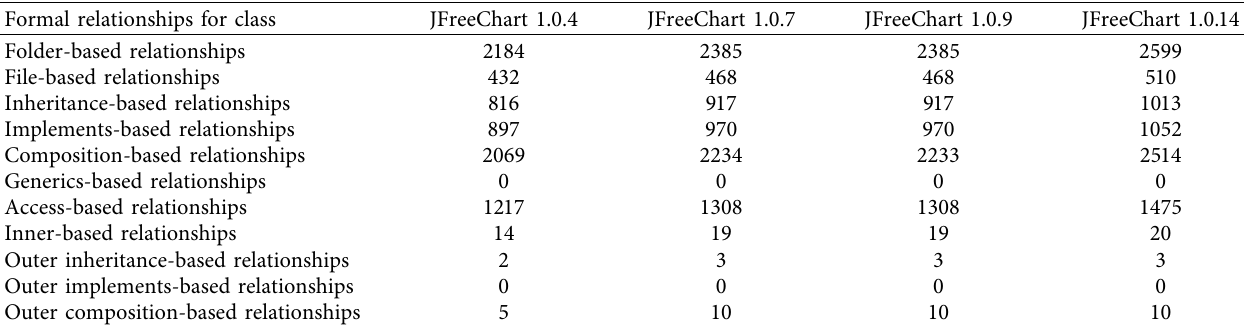
Table 13: Formal relationships for class in JFreeChart.